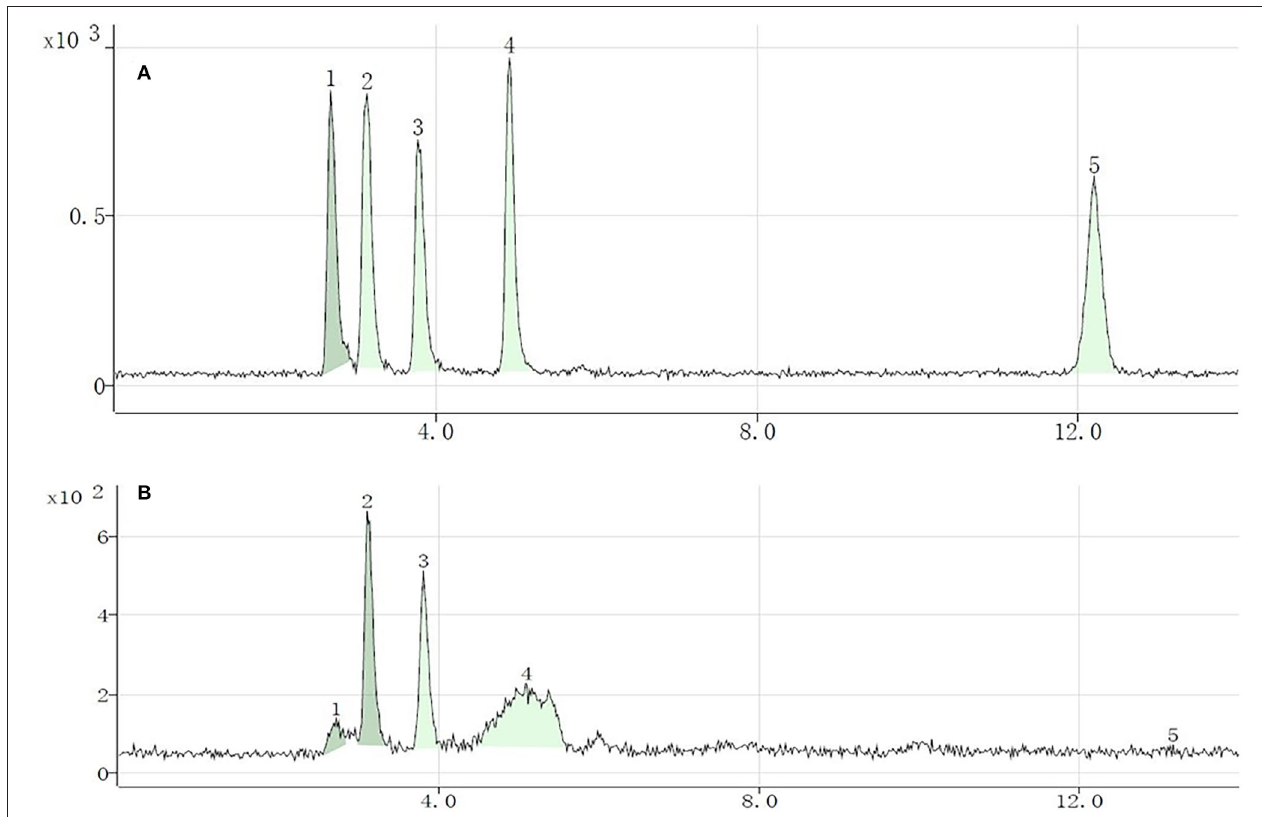
FIGURE 2 | Concentration (A) and proportions (B) of Se species in soybean and proteins under different treatments. Different letters are used to show significant differences at various treatments ( p < 0.05).